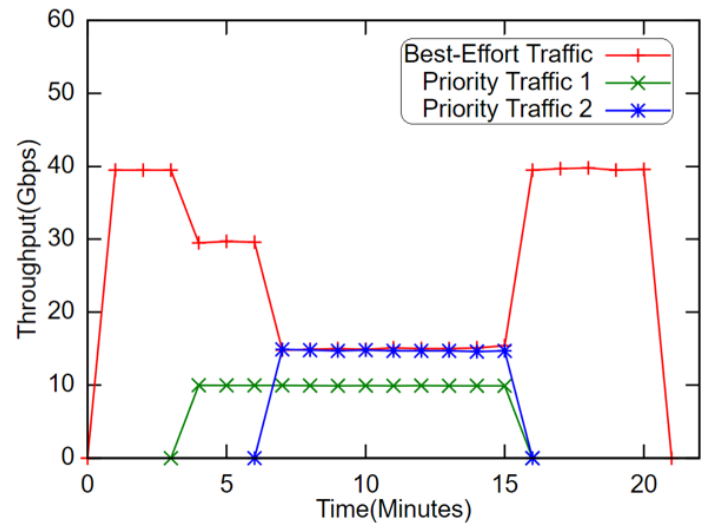
Figure 5. Extreme-scale evaluation results.